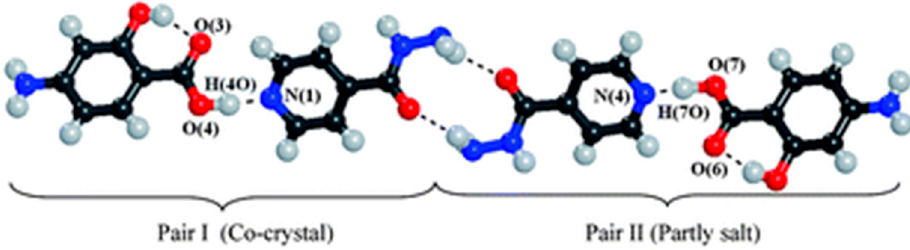
Figure 6. COOH···N pyridine and amide-amide dimer synthon between the symmetry independent molecules of INH-PAS cocrystal. Adapted with permission from CrystEngComm , 2011, 13 , 4358–4364. Copyright 2011, The Royal Society of Chemistry.